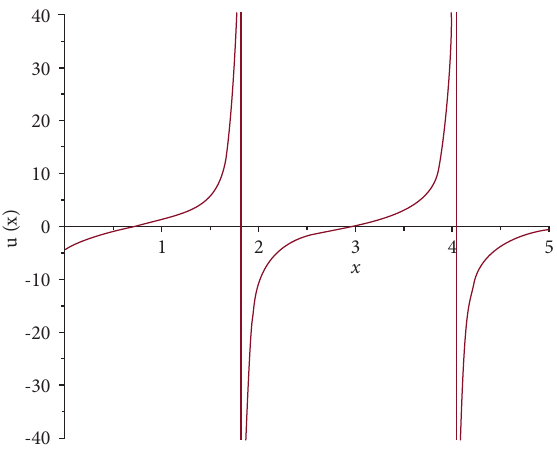
given in (49) for a � − 2, α � 1, and c � 100. 9